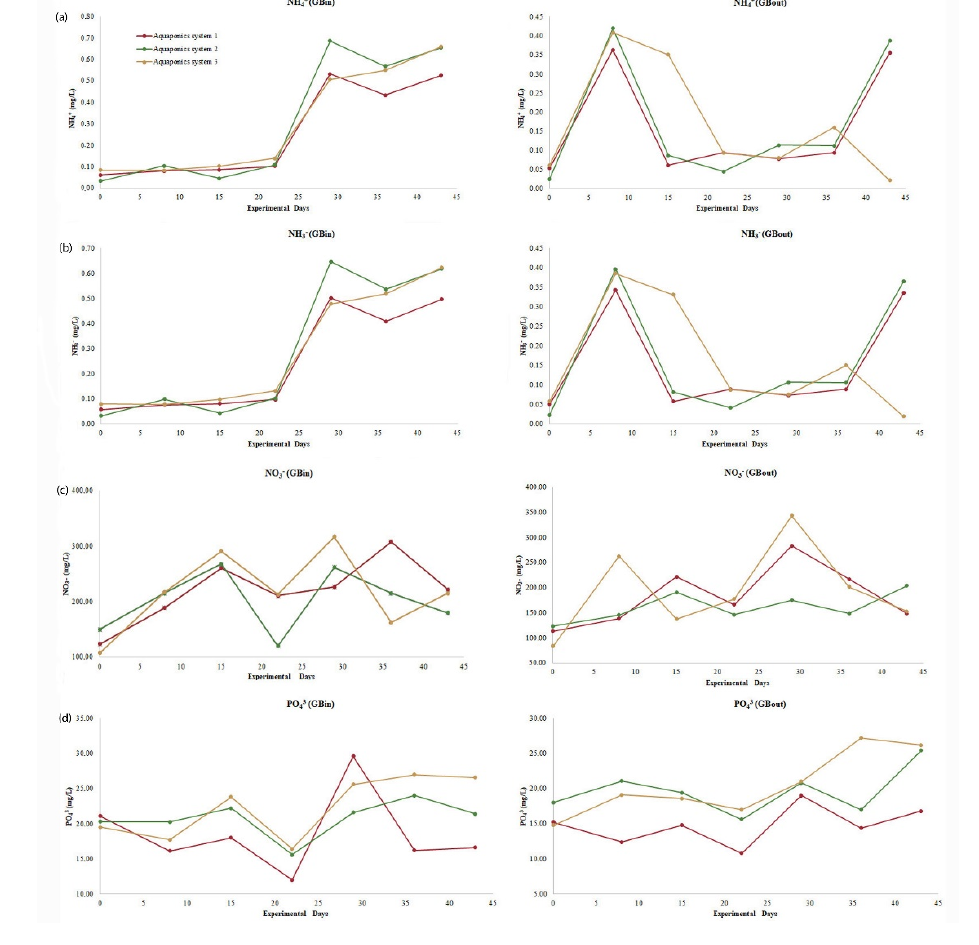
Table 4. Functional characteristics of the filters in the aquaponic systems over the 45-day period. Filter Indices